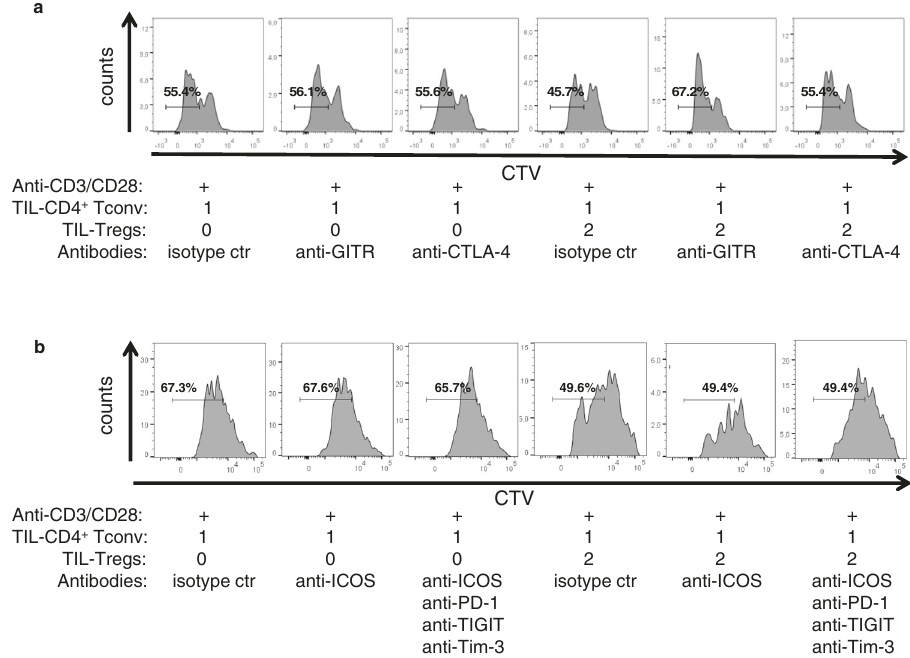
Fig. 7 Impact of ICP blockade targeting Tregs on the proliferation of CD4 + Tconv. The proliferation of sorted CD2 + CD8 − CD4 + CD127 + TIL-CD4 + Tconv was measured by analyzing CTV dilution during cell culture with anti-CD3/anti-CD28 coated beads (1 bead/10 cells) with or without autologous sorted CD2 + CD8 - CD4 + CD25 bright CD127 − TIL-Tregs with or without neutralizing antibodies against CTLA-4 and GITR ( a ), and ICOS, PD-1, TIGIT, and Tim-3 ( b